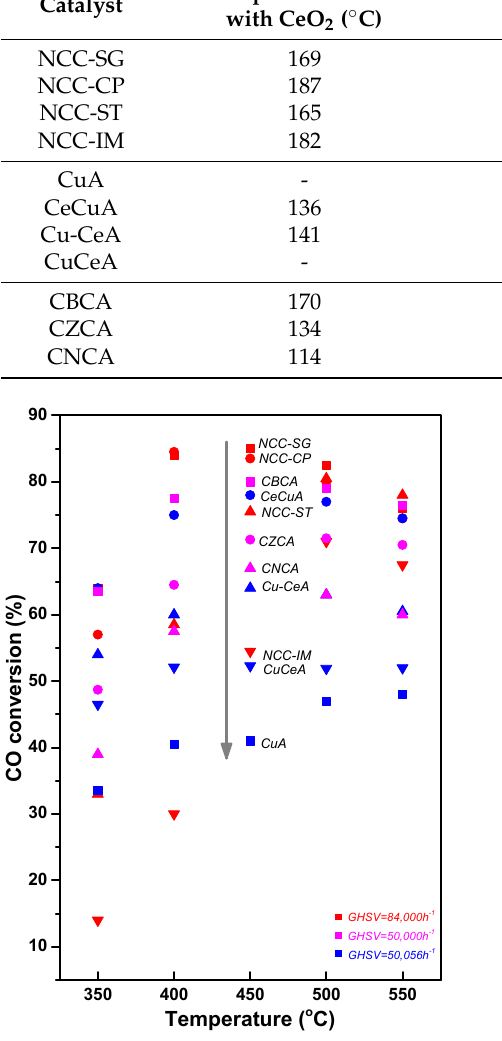
Figure 4. CO conversion of Cu-based catalysts. Table 6. Reduction Temperature of Cu-based catalysts. Catalyst